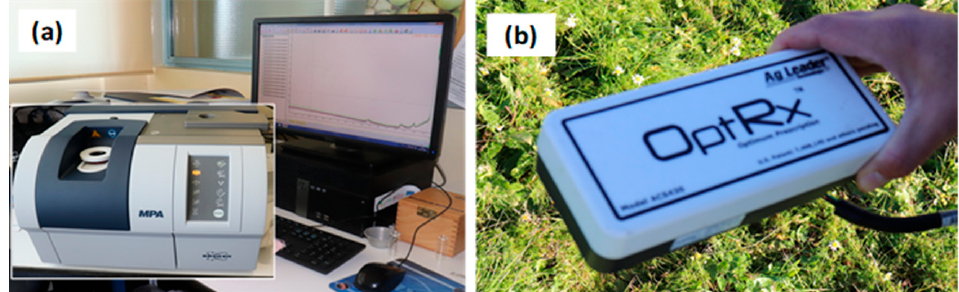
Figure 4. Near ‐ infrared spectrometer ( a ) and active optical sensor ( b ) used in Figure 4. Near-infrared spectrometer ( a ) and active optical sensor ( b ) used in this this study.